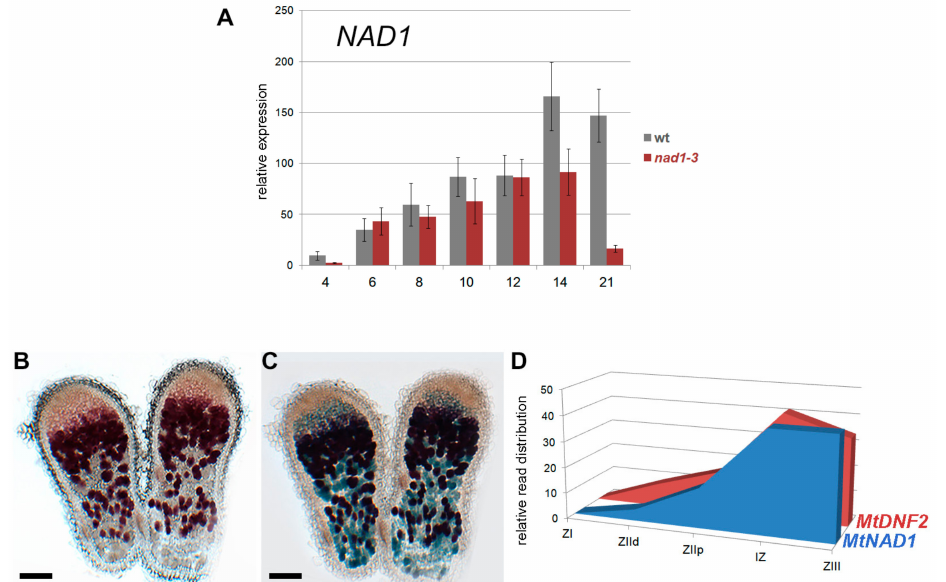
Figure 3. NAD1 is induced following rhizobial inoculation and predominantly expressed in the intermediate and nitrogen fixation zones of Medicago truncatula nodules. ( A ) The expression level of NAD1 during nodule development in wild-type Jemalong and nad1-3 M. truncatula plants inoculated with S. medicae WSM419 (pXLGD4). The transcript levels were identified by reverse transcription quantitative polymerase chain reaction (RT-qPCR) using three biological replicates and calculated relative to the expression detected in wild-type at 0 dpi; x -axis shows dpi. The results were normalized using an UBQ- like gene and PTB. Error bars indicate ± SE. ( B – D ) NAD1 is expressed in the infected cells of the infection zone, the intermediate zone and the nitrogen-fixation zone of M. truncatula nodules. The NAD1 promoter- β -glucuronidase (GUS) fusion reporter construct ( pNAD1::GUS) was introduced into the roots of wild-type plants with Agrobacterium rhizogenes mediated hairy root transformation. Roots were inoculated with S. medicae WSM419 expressing the lacZ reporter gene. Nodules on transformed roots at 14 dpi were stained first for GUS activity using the ( B ) Magenta-Gluc substrate followed by staining for ( C ) β -galactosidase activity to display the presence of rhizobia. Scale bars: 200 µ m. ( D ) Relative spatial expression of NAD1 and DNF2 generated with RNA sequencing of different nodule zones obtained with laser-capture microdissection described in the study by [47]. Both NAD1 and DNF2 are expressed in the zones of the indeterminate nodule of M. truncatula containing colonized cells. ZI: zone I (meristem); ZIId: invasion zone distal; ZIIp: invasion zone proximal; IZ: intermediate zone; ZIII nitrogen-fixation